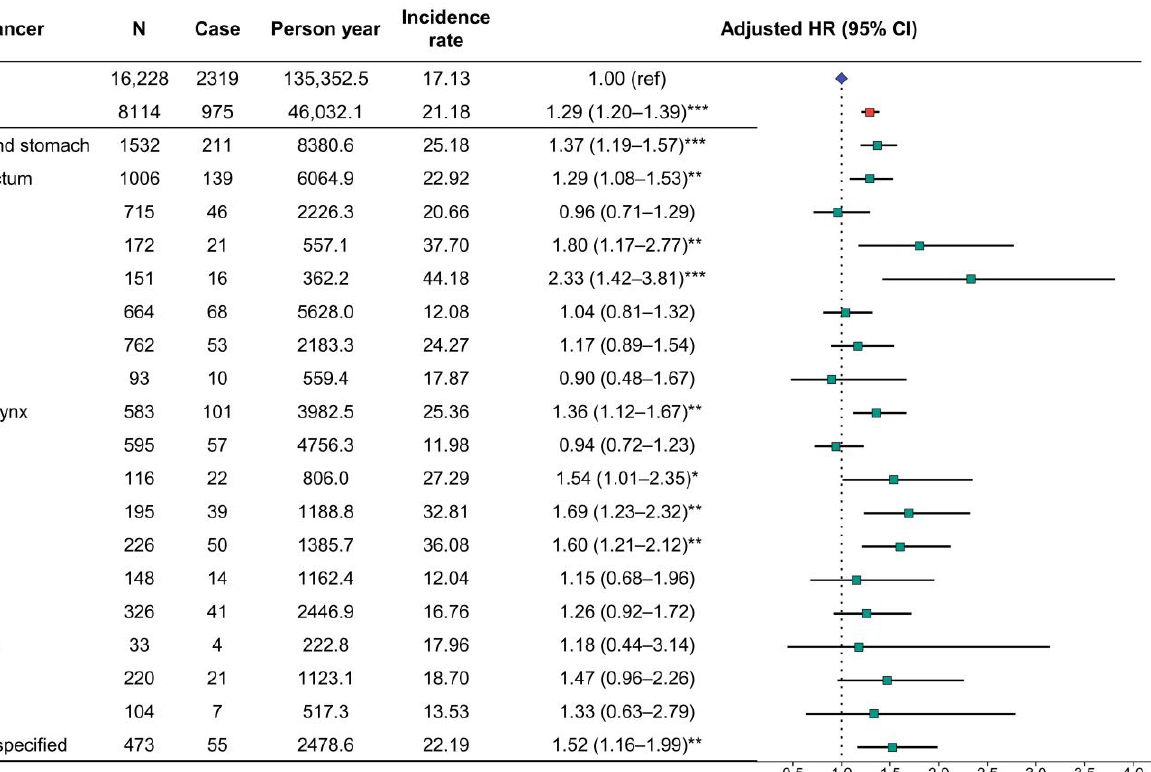
Figure 2. Incidence rate and hazard ratio of type 2 diabetes by cancer type. * p < 0.05, ** p < 0.010, and *** p < 0.001. Table 1. Sensitivity analysis: incidence and risk of incident diabetes associated with cancer patients who excluded those diagnosed with pancreatic